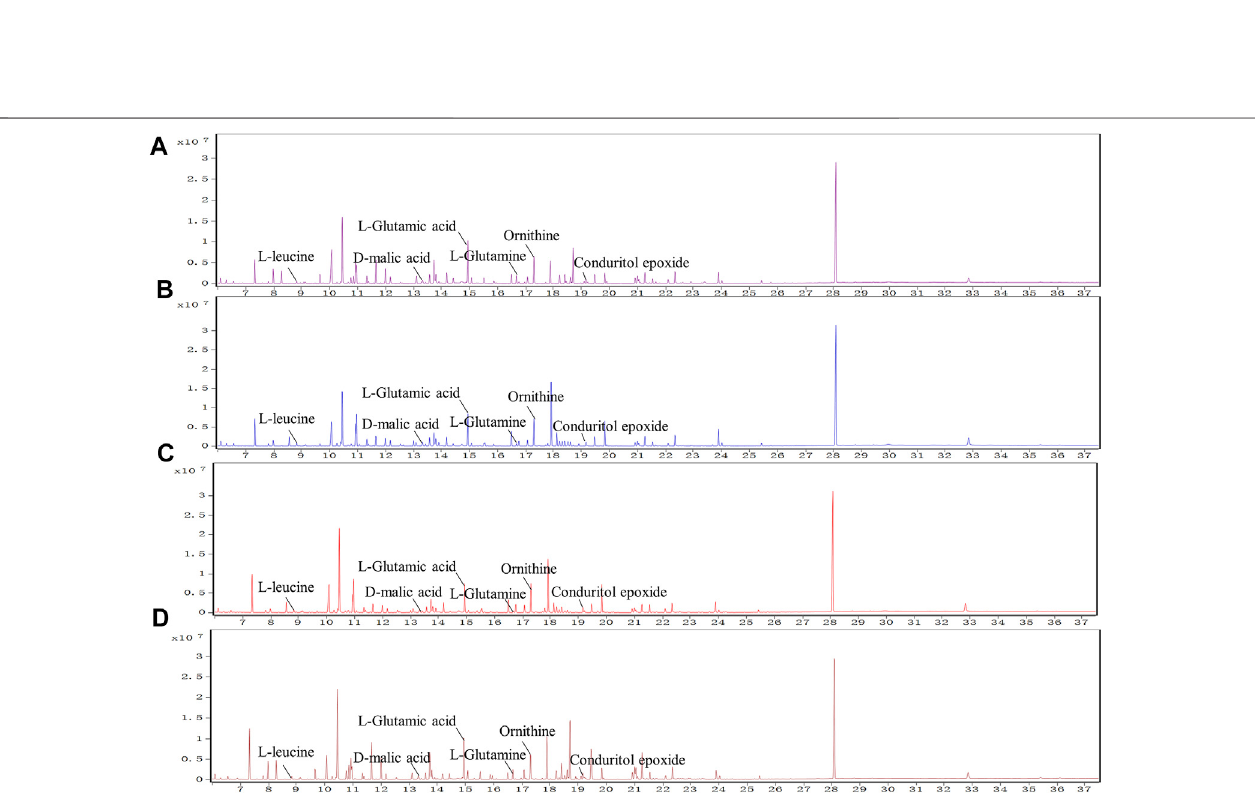
Frontiers in Pharmacology |